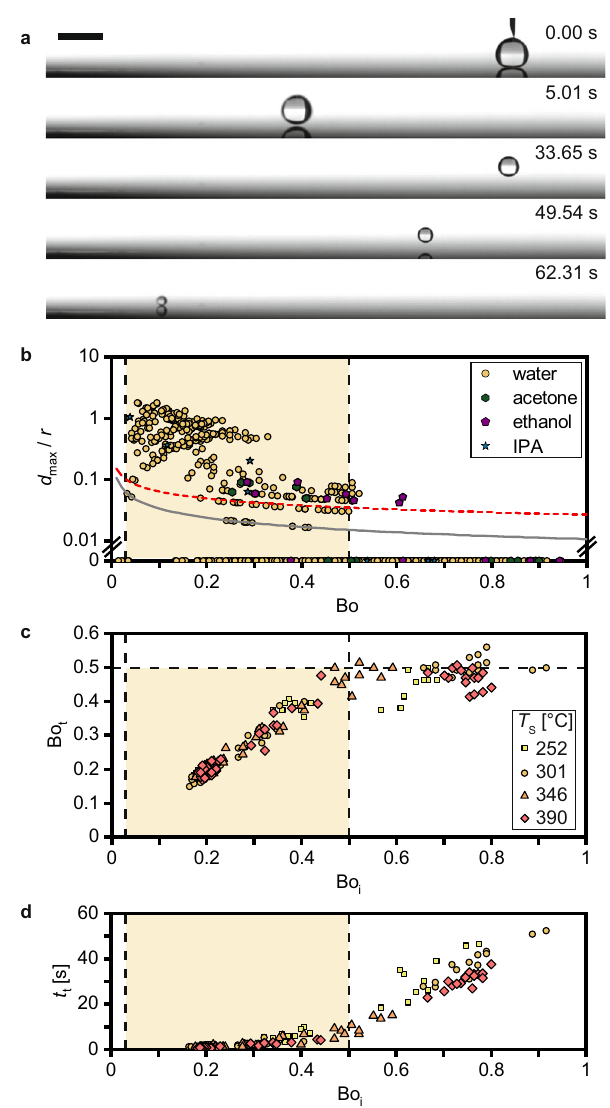
Fig. 2 The effect of droplet Bond number on Leidenfrost trampolining. Liquid droplets gently deposited on a concave silicon wafer heated above the Leidenfrost temperature. a Long-term observation of a water droplet with an initial Bond number, Bo i = 0.3 (initial droplet radius, r i = 1.4 mm), and surface temperature, T S = 302 °C. Time-zero is when the droplet detaches from the needle (Supplementary Movie 2). The scale bar represents 4 mm. b Maximum gap height during a jump divided by the instantaneous droplet radius, d max / r , as a function of the Bond number, Bo, at T S = 301 ± 3 °C extracted from n = 70 independent experiments for water (yellow circle), acetone (green hexagon), ethanol (purple pentagon) and isopropyl alcohol (IPA, blue star), see Supplementary Movie 3. The red dashed line represents the equilibrium vapor layer thickness d 0 (computed for water and T S = 300 °C, see Supplementary Text on Leidenfrost Modeling), and the gray line is the lower limit of optical resolution in our experiments. Data points at d max / r = 0 represent non-trampolining droplets. c , d Droplet Bond number at the fi rst trampolining jump, Bo t , and time passing until the start of Leidenfrost trampolining, t t , vs. Bo i for different T S measured for n = 215 independent experiments. 90% of the experiments showed Leidenfrost trampolining. The legend shows the mean for T S with a standard deviation of ±3 °C around the mean. Source data are provided as a Source Data fi